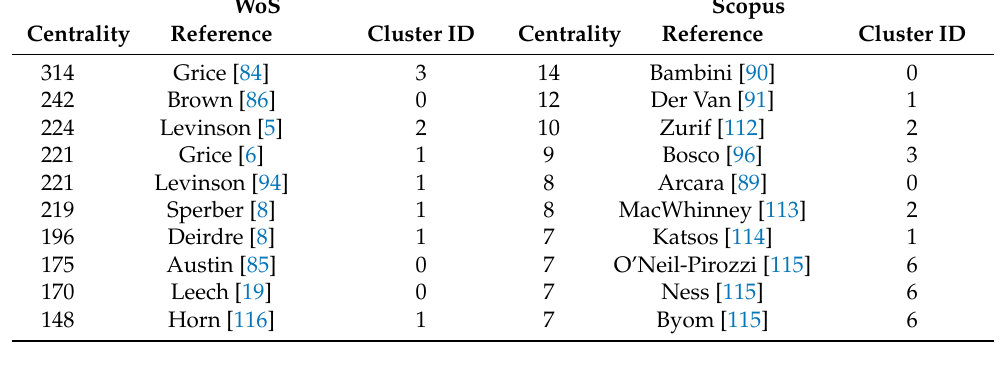
Table 7. Centrality calculation for top central authors in pragmatics.